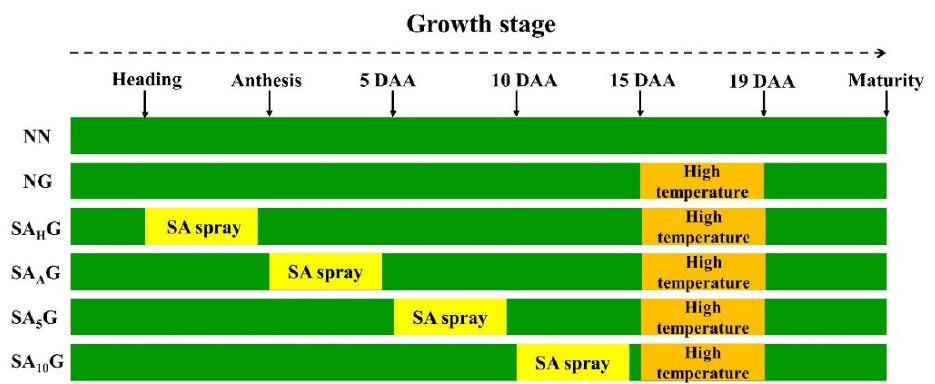
Figure 1. Schematic representation of experimental design and treatments. DAA refers to days after anthesis. NN is the control (normal growth conditions outside the shed). NG represents non-SA spraying and high temperature stress at the grain-filling stage. SA H G represents exogenous SA spraying at the heading stage and high temperature stress at the grain-filling stage. SA A G represents exogenous SA spraying at the anthesis stage and high temperature stress at the grain-filling stage. SA 5 G and SA 10 G represent treatments whereby exogenous SA was sprayed starting from 5 and 10 DAA and high temperature stress at the grain-filling stage.